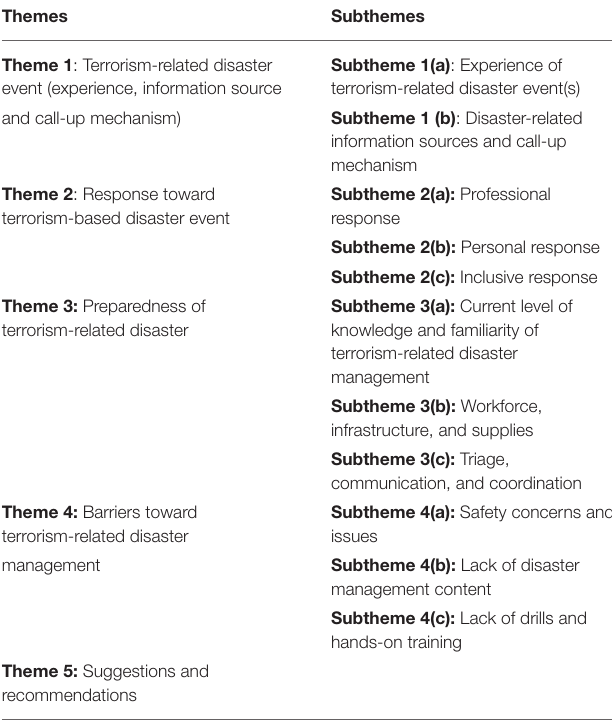
TABLE 1 | Demographic characteristics of the respondents. Characteristics